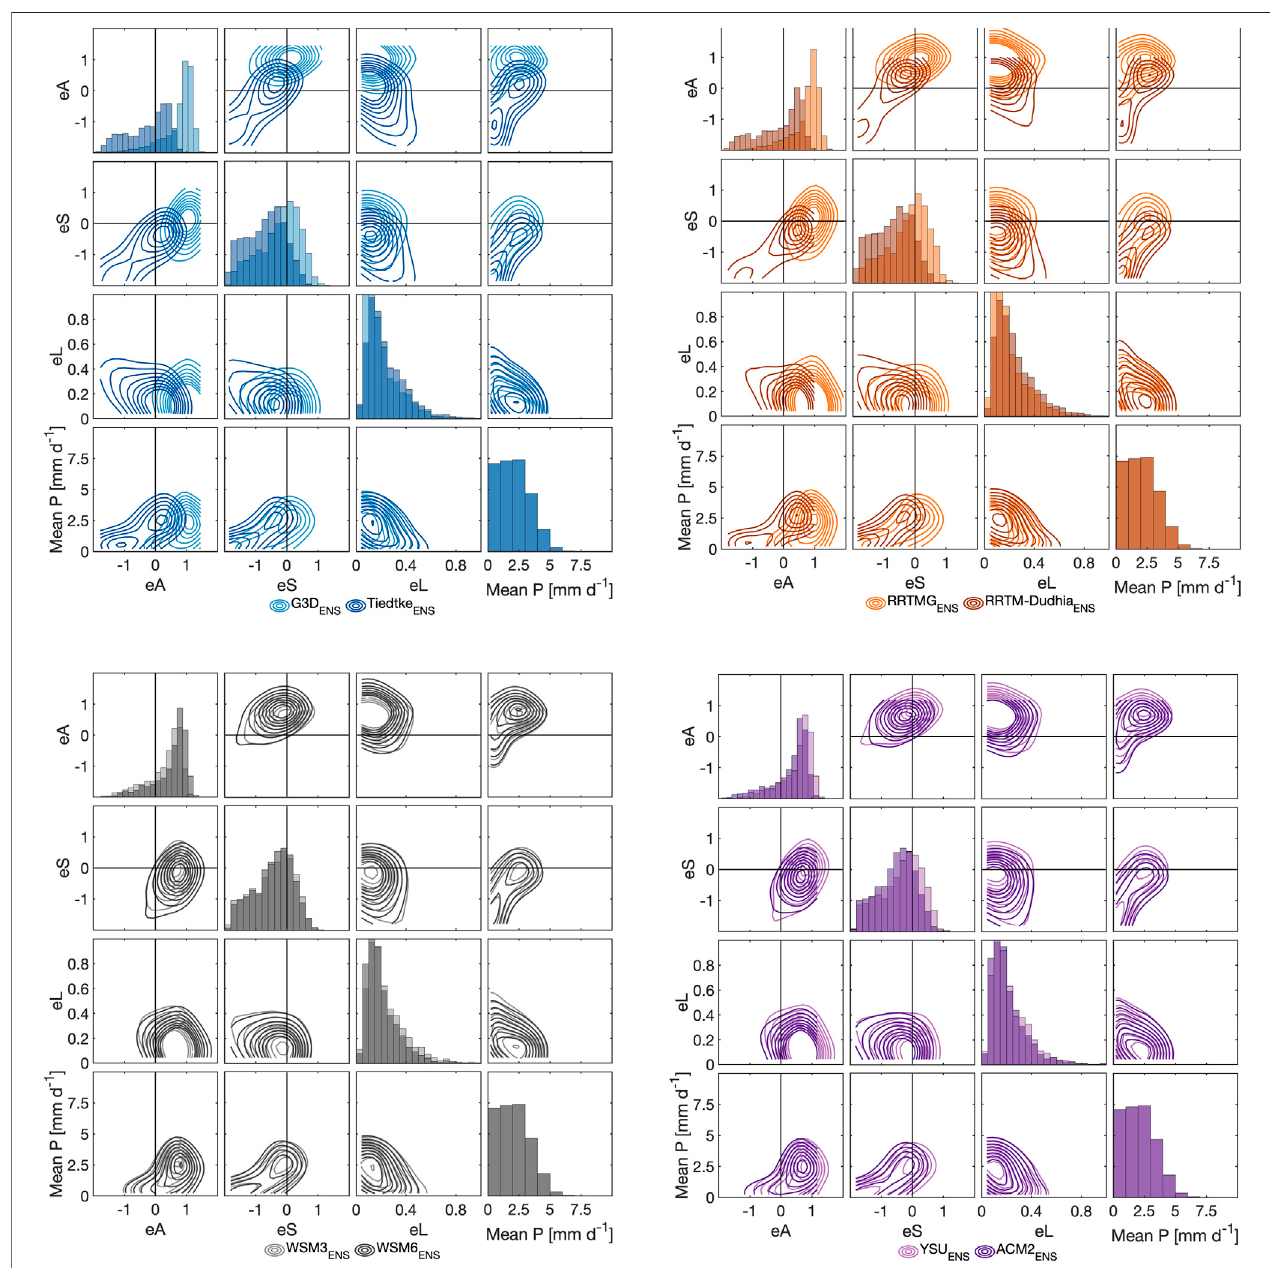
FIGURE 6 | Validation of the domain-averaged precipitation (amplitude, A), the structure (volume, S), and the location (L) of precipitation objects for the ensembles (e), consisting of eight cumulus- (blue), radiation- (orange), microphysics- (grey), and planetary boundary layer (magenta) parameterization runs, respectively (see Table 2 ), for the period 2006 – 2010. The reference data is the ERA5-Land. Note that all the subplots are symmetrical to the main